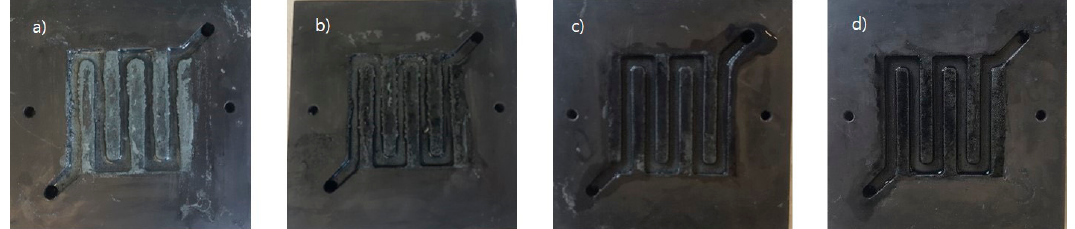
Figure 2. Zinc-side bipolar plate after charging: ( a ) 0% carbon black (CB), ( b ) 0.2% CB, ( c ) 0.6% CB, ( d ) 1% CB.